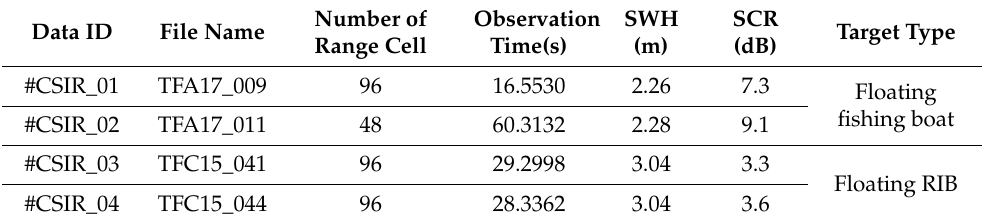
Table 2. Description of the CSIR data used in this paper.